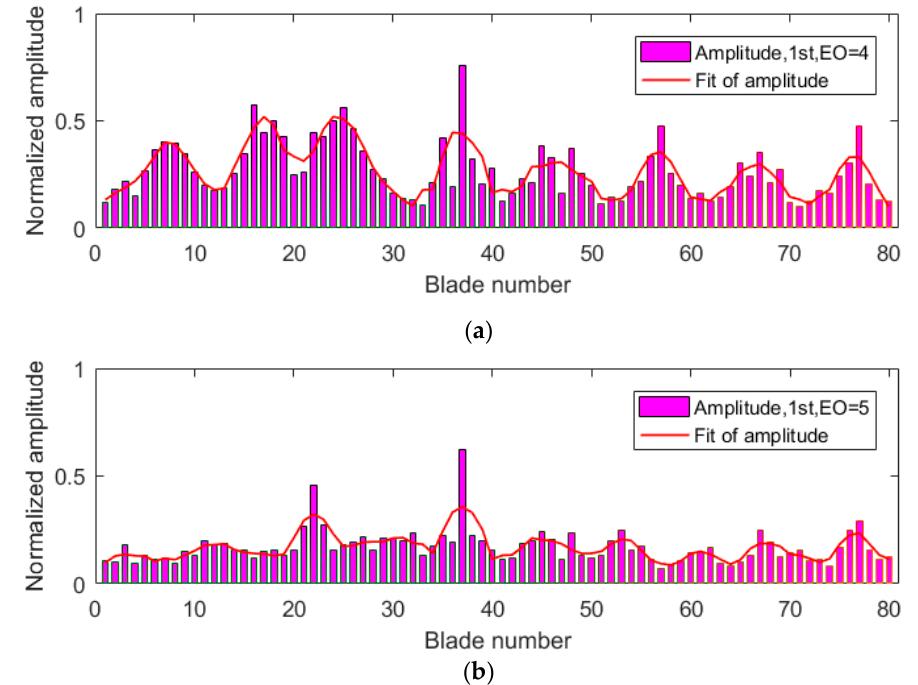
Figure 10. Normalized amplitudes of all blades in the first test: ( a ) engine order (EO) = 4 and ( b ) EO = 5.